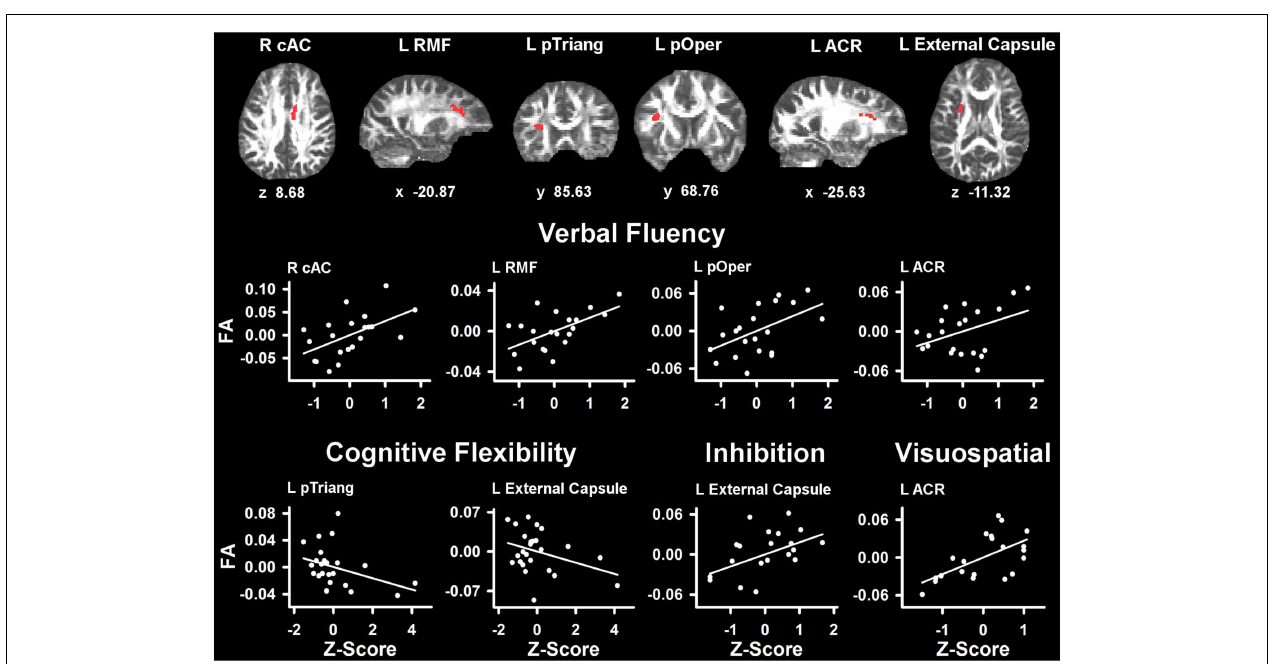
deviation. Higher Z scores reflect better performance, except for cognitive flexibility where higher values signify worse performance (i.e., longer time to completeTrails Part B after subtracting Part A performance).The spatial location of FA in each ROI is displayed in diffusion space for representative individual subjects. L, left hemisphere; R, right hemisphere; ARC, anterior corona radiata; cAC, caudal anterior cingulate; pOper, pars opercularis; pTriang, pars triangularis; RMF, rostral middle frontal. Coordinates designate distance in millimeters. from anterior commissure: x , left ( − )/right ( + ); y , anterior ( + )/posterior ( − ); and z , superior ( + )/inferior ( −